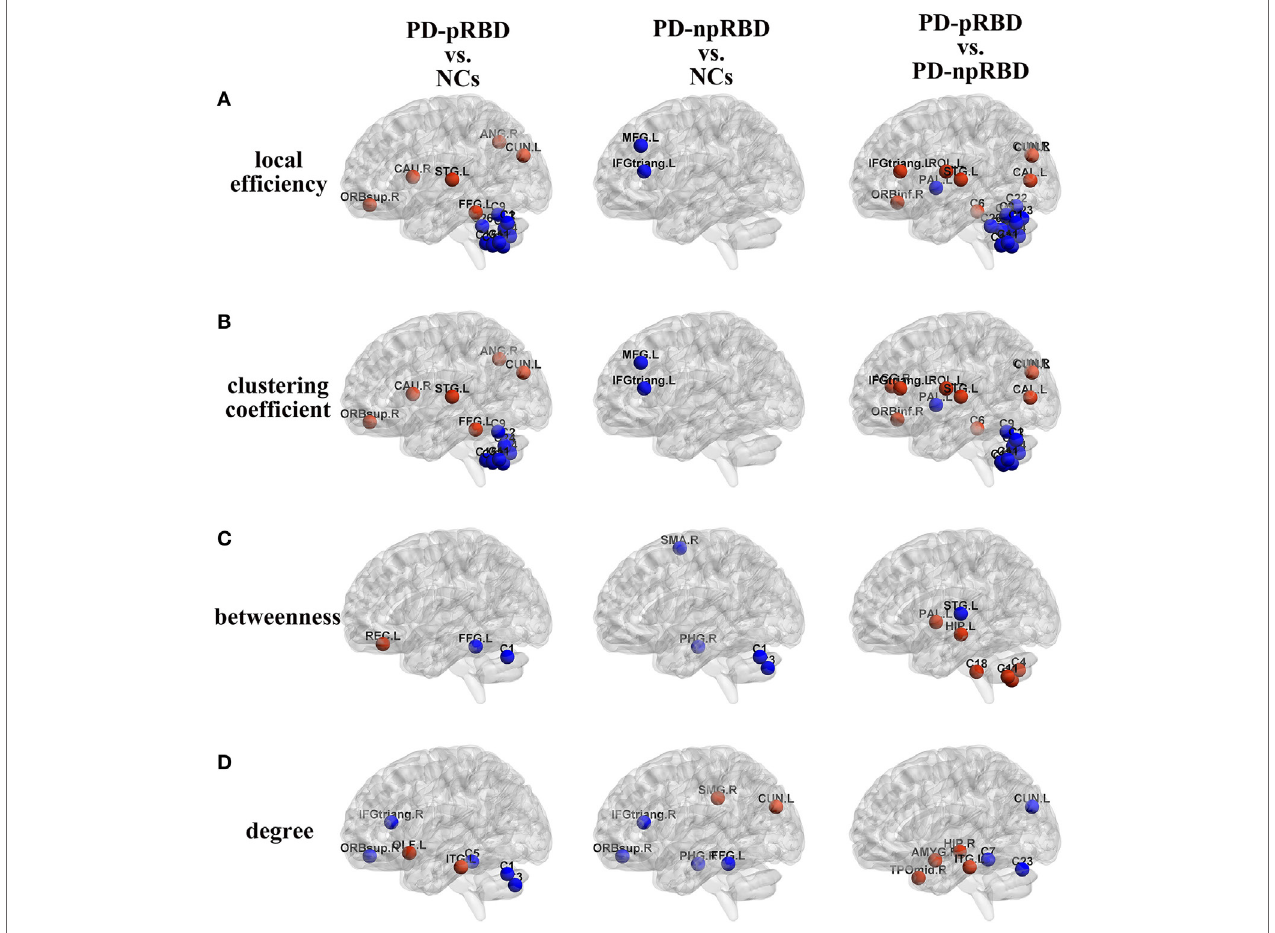
FigUre 3 | Group differences of (a) local efficiency, (B) clustering coefficient, (c) betweenness, and (D) degree between any two groups [Parkinson’s disease (PD) patients with possible rapid eye movement sleep behavior disorder (RBD) (PD-pRBD) vs. normal controls (NCs), PD patients with non-possible RBD (PD-npRBD) vs. NCs and PD-pRBD vs. PD-npRBD]. The red (blue) nodes in three panels, respectively, indicated increased (decreased) regional network measures in PD-pRBD (vs. NCs), PD-npRBD (vs. NCs), and PD-pRBD (vs. PD-npRBD). The results were visualized using the BrainNet Viewer (Beijing Normal University, http://www.nitrc. org/projects/bnv/). Abbreviations were presented in Table S3 in Supplementary